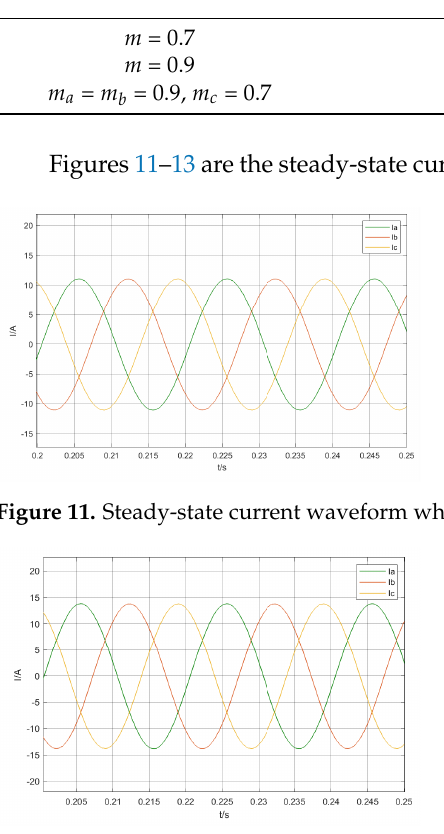
Figure 12. Steady-state current waveform when m = 0.6, D = 0.1.